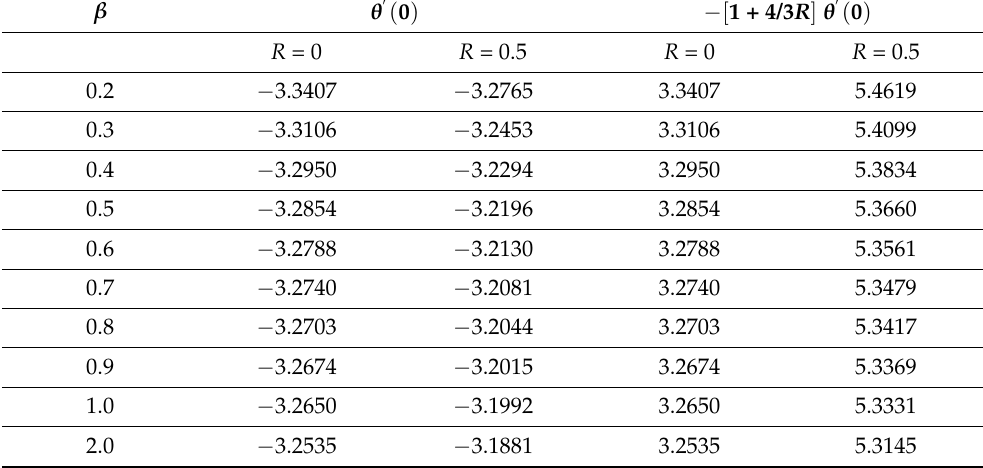
Table 11. Impact of Casson fluid parameter on Nusselt number for radiative and non-radiative flow fields.